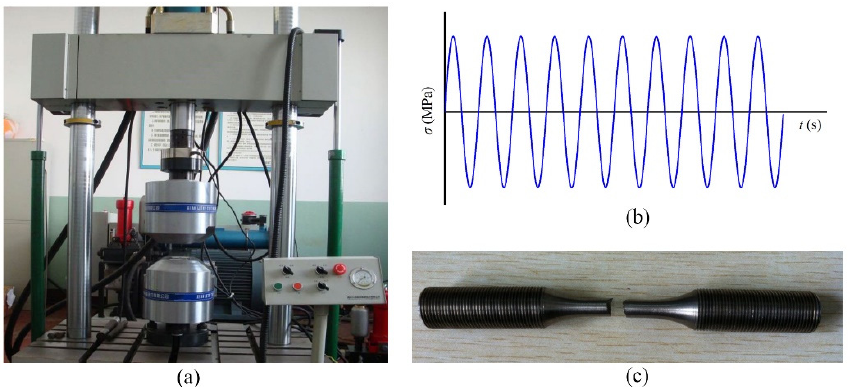
Figure 15. Fatigue test of Ti-6Al-4V titanium alloy. ( a ) Equipment of fatigue test; ( b ) The test loads; ( c ) The fractured specimen of fatigue test.